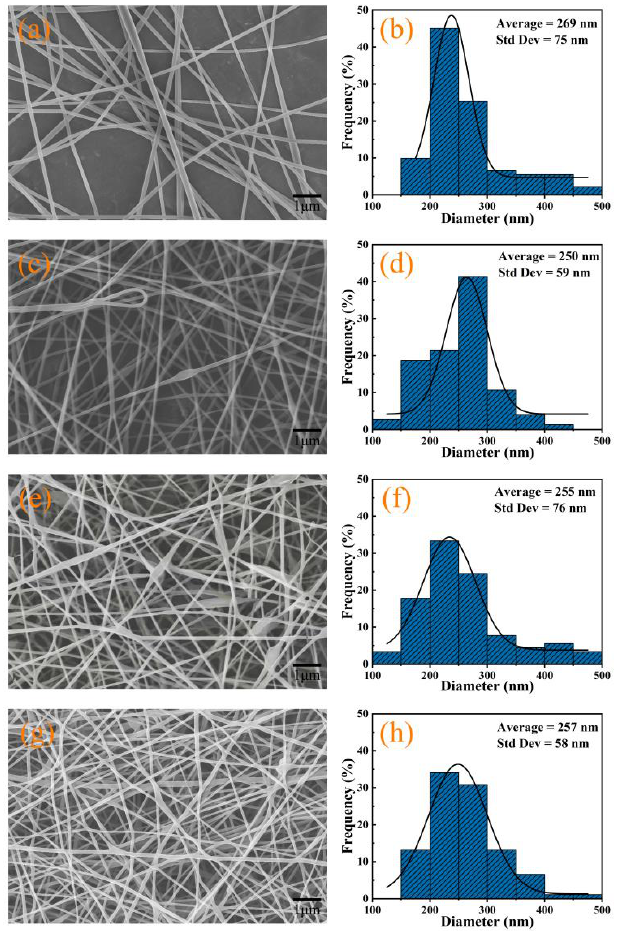
Figure 1. SEM images and fiber diameter distributions for nanofibers: ( a , b ) PVP-0; ( c , d ) TTE-PVP-1; ( e , f ) TTE-PVP-2; ( g , h ) TTE-PVP-3.